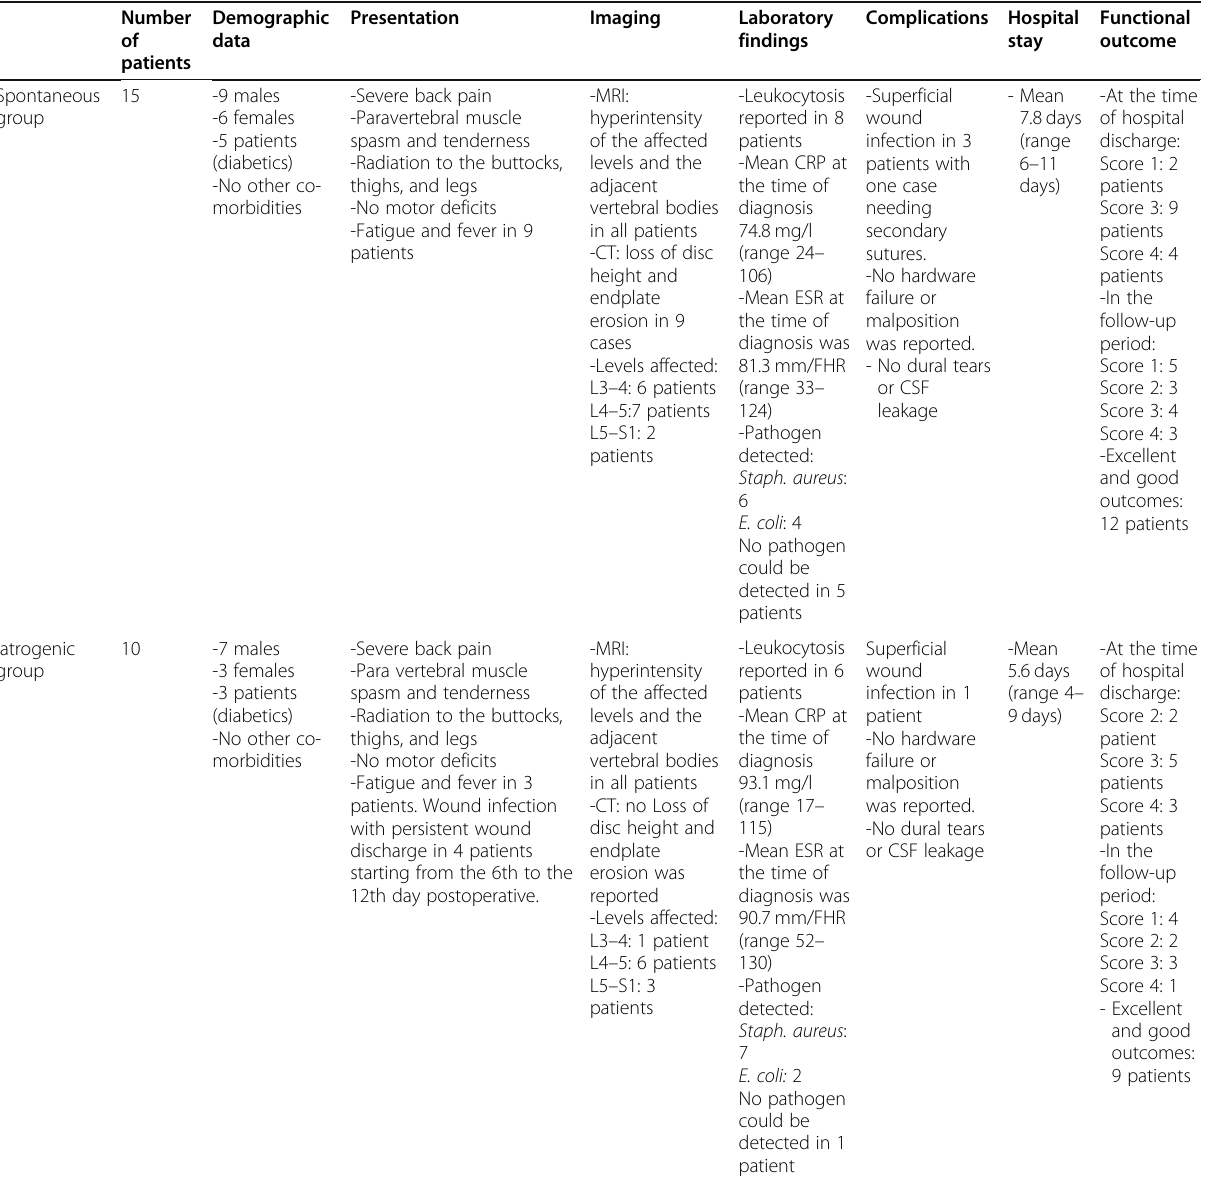
Table 2 Summary of patients ’